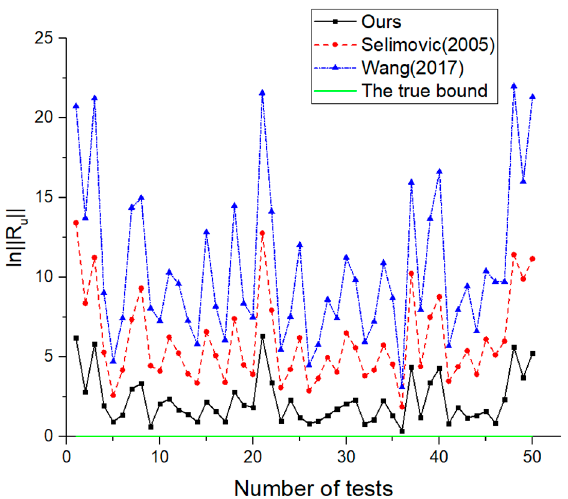
( ) R u of NURBS surfaces with u